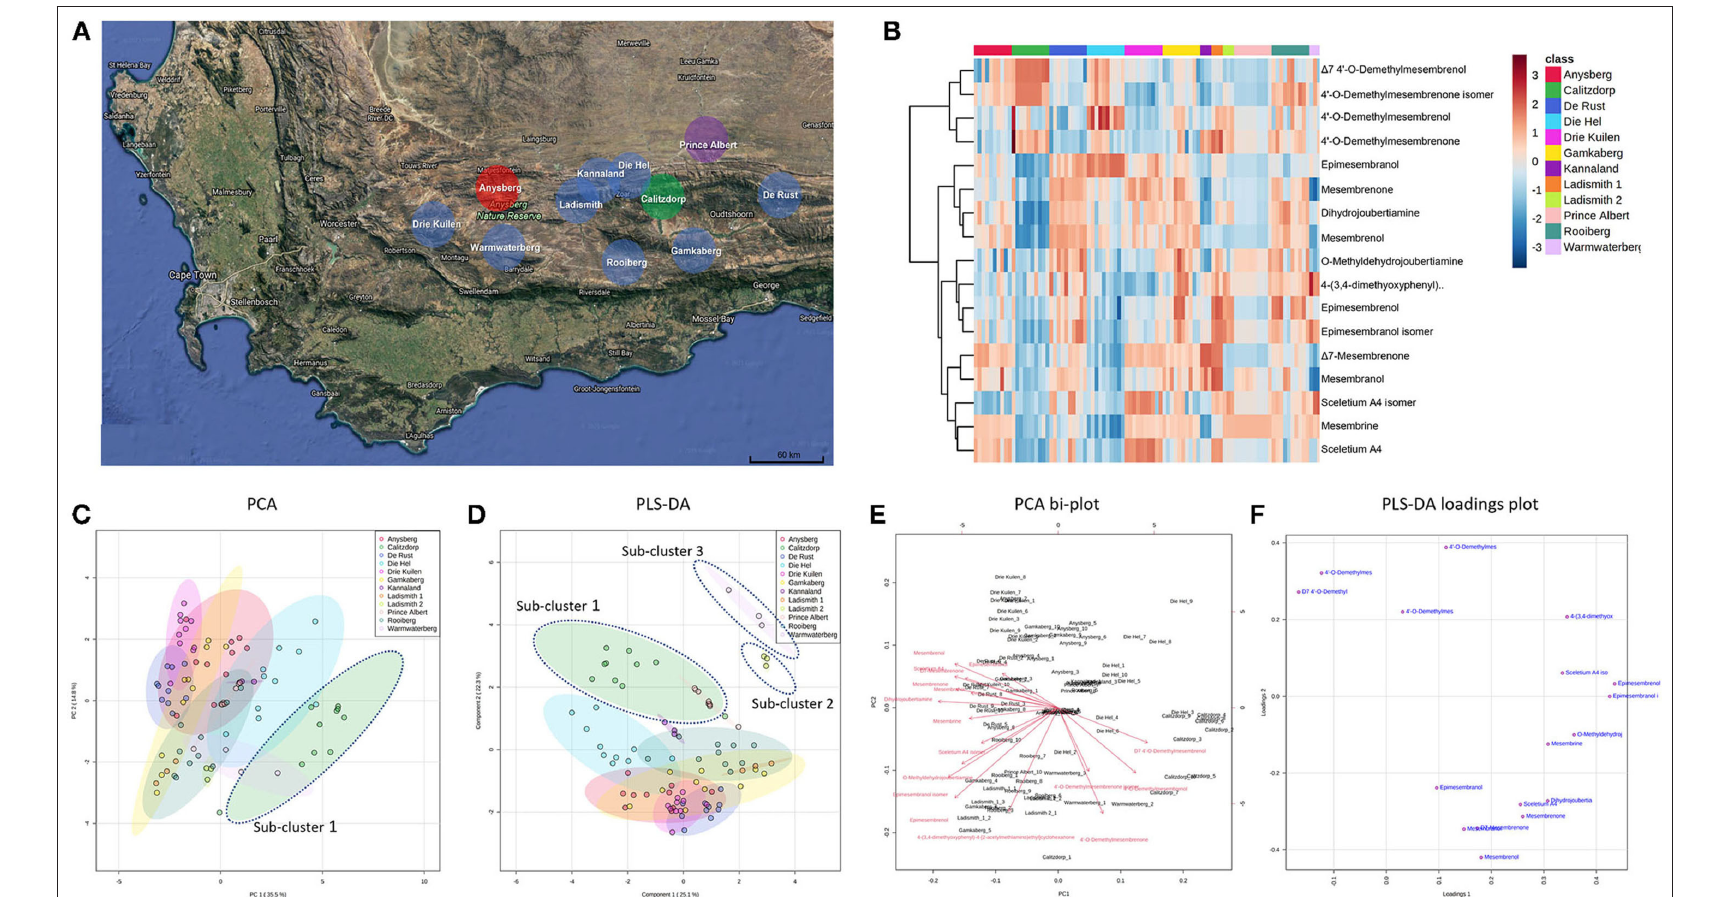
FIGURE 2 | (A) Map showing geographic locations of S. tortuosum (blue), S. strictum (red), S. rigidum (purple) and S. emarcidum (green) found in South Africa; (B) Heat-map illustrating alkaloid diversity of tentatively identified alkaloids from all twelve Sceletium populations; (C) Principal component analysis (PCA) on all populations of Sceletium .; (D) Supervised partial least squares discriminant analysis (PLS-DA) on all populations of Sceletium ; (E) PCA bi-plot of phytochemicals contributing to separation; (F) PLS-DA loadings plot of phytochemicals contributing to